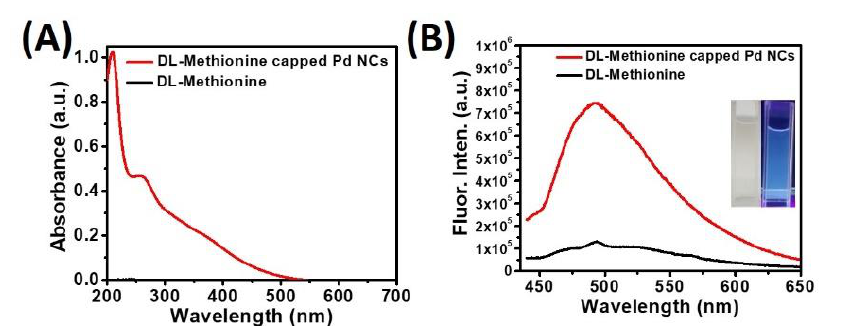
Figure 2 . Optical and fluorescence properties of Pd NCs. ( A ) UV-vis absorbance spectra and ( B ) fluorescence emission spectra of Pd NCs and DL-Methionine at a photoexcitation wavelength of 420 nm (inset represents the bluish green fluorescence images of Pd NCs under UV lamp, 365 nm).